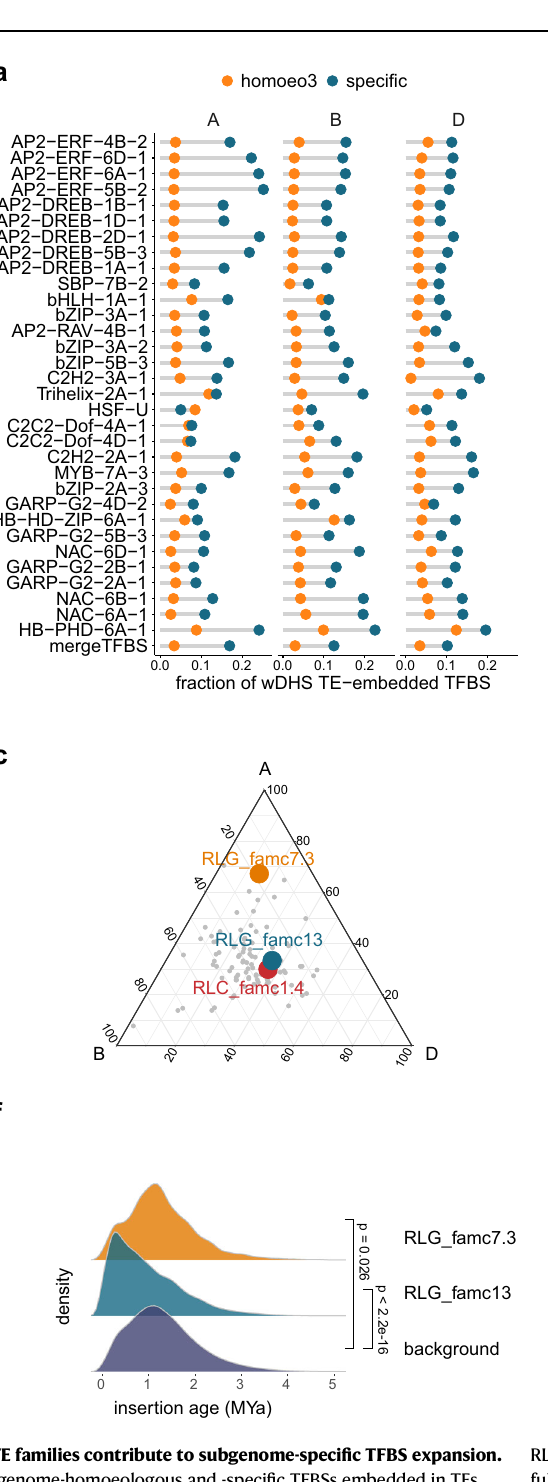
RLG_famc7.3 members. e Dendrogram presenting the sequence similarity of the full-length RLG_famc13 members. f . Age distribution of TEs enriched in the TFBSs determined according to the sequence similarity of the LTR at both ends. We correctedtheK2Pdistancedistributionbyusingtheknownevolutionaryhistoryas a reference: age=distance/(2× mutation rate), with a mutation rate of 1.3×10 − 8 as previously described 10 . The two-tailed Wilcoxon signed-rank test was used